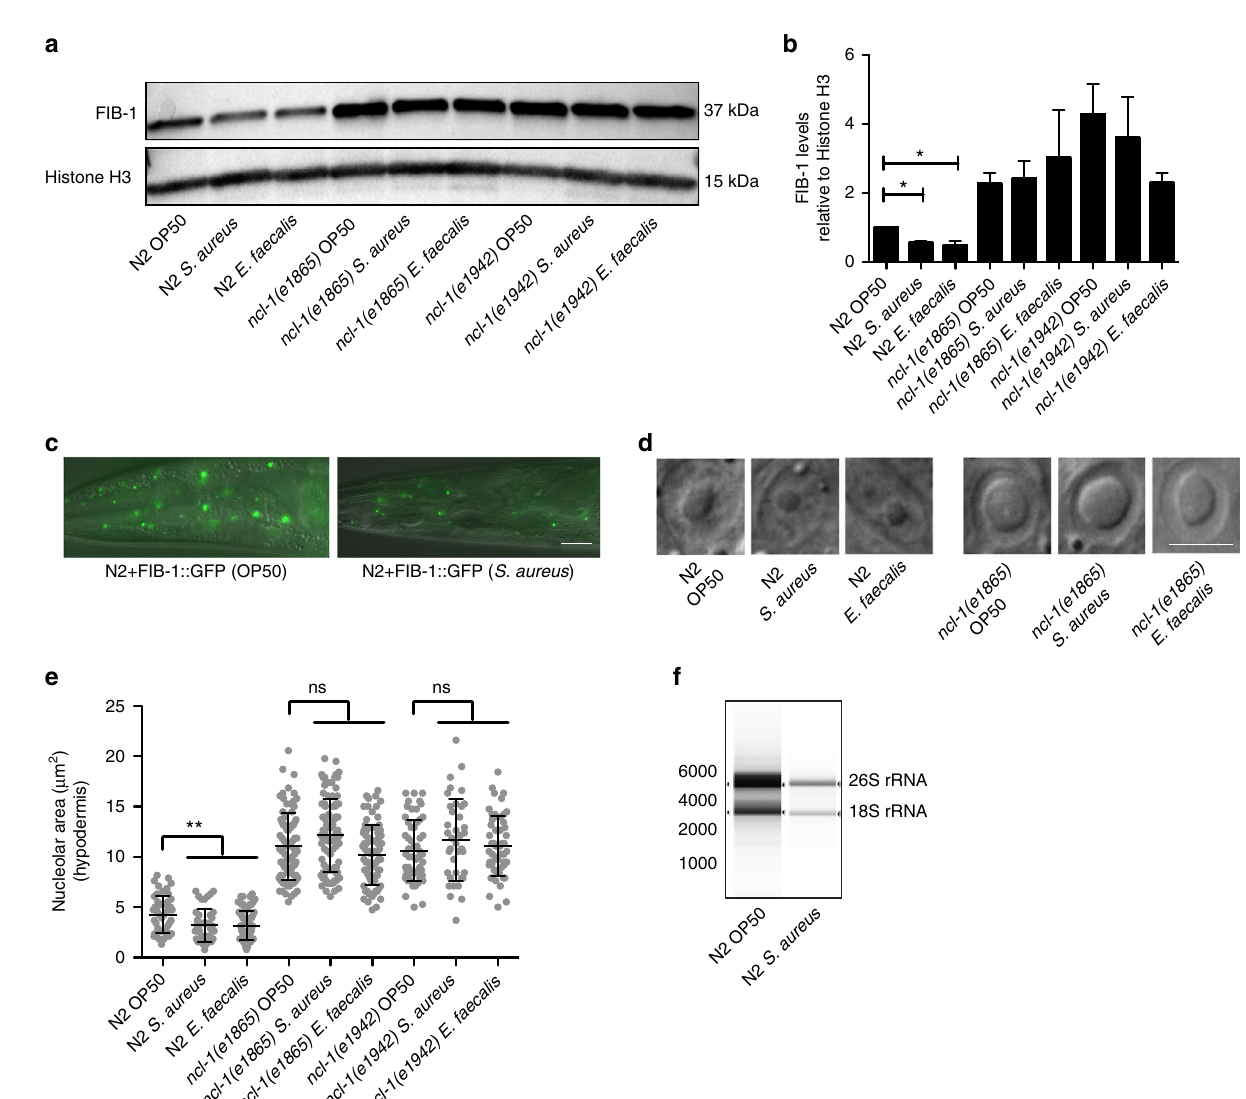
Fig. 2 FIB-1/ fi brillarin and nucleolar size are reduced upon bacterial infection. a , b FIB-1 levels are signi fi cantly reduced in wild-type N2 after S. aureus and E. faecalis infection. FIB-1 is modestly reduced in ncl-1 mutants after infection but the levels are still higher relative to wild-type N2 after infection. Error bars represent mean ± s.e.m. of three independent biological replicates. c FIB-1::GFP shows reduced fl uorescent signal after infection with S. aureus . d , e Nucleolar size in hypodermal cells of wild-type N2 worms is reduced after 12-h infection with S. aureus and E. faecalis . Nucleolar size in hypodermal cells of ncl-1 mutants after infection remains unaffected. Error bars represent mean ± s.d. f S. aureus infection for 12 h reduces 26S and 18S rRNA levels in wild- type C. elegans . RNA extracted from equal number of uninfected and infected worms was analyzed using a bioanalyzer. Scale bars represent 20 ( c )